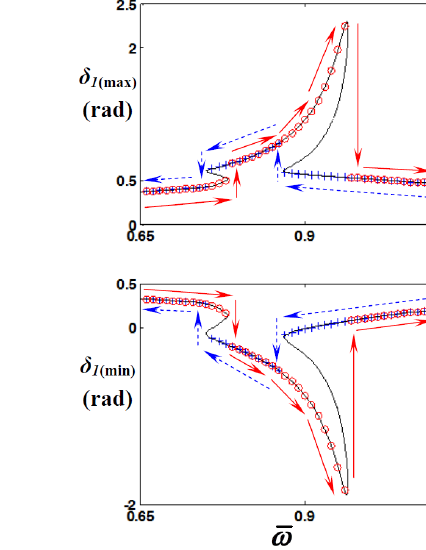
t  ; ( b ) illustration of jumping 1 → , flow of